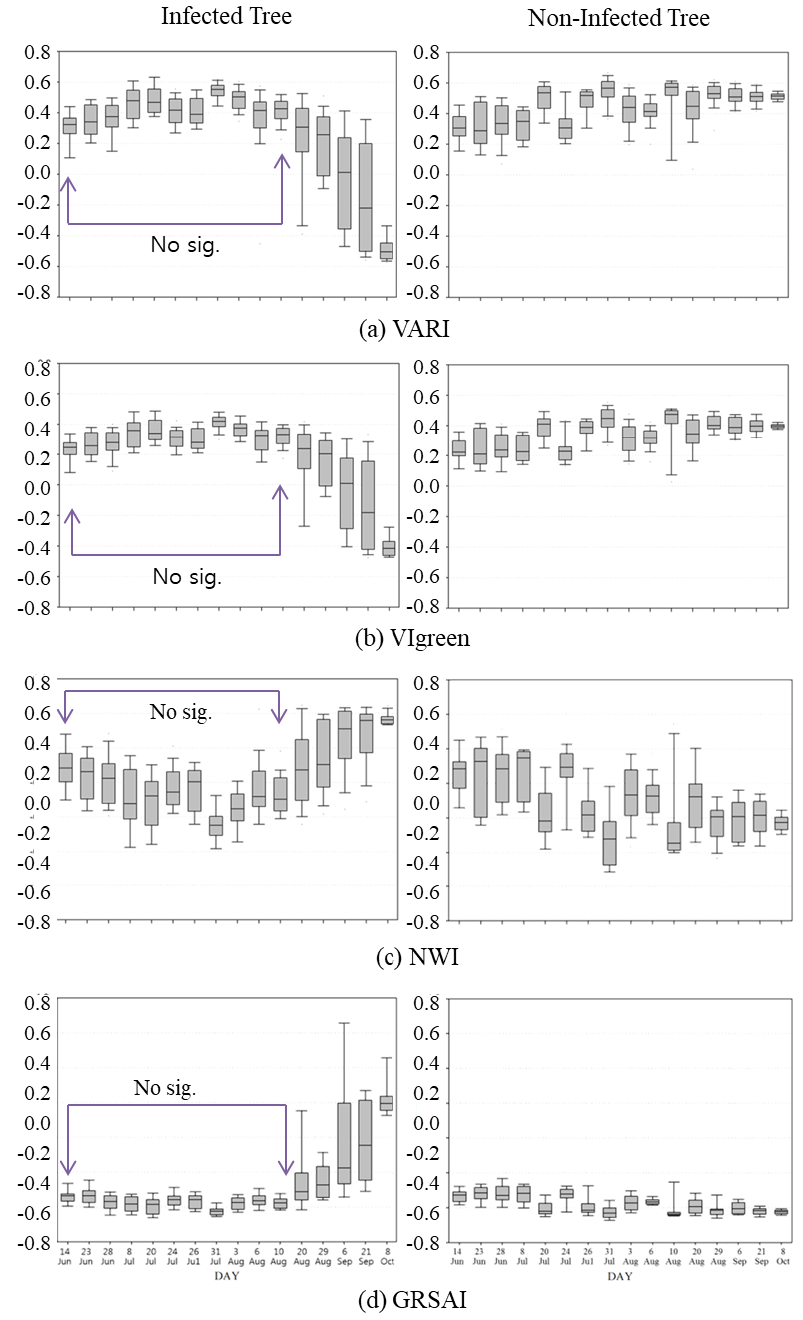
Figure 5. Changes in vegetation reflectance indices (VARI, VIgreen, NWI, GRSAI) over time.